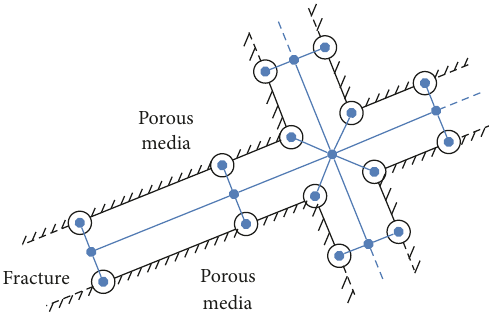
Figure 2: The meshing example for 2D intersecting fractures with the